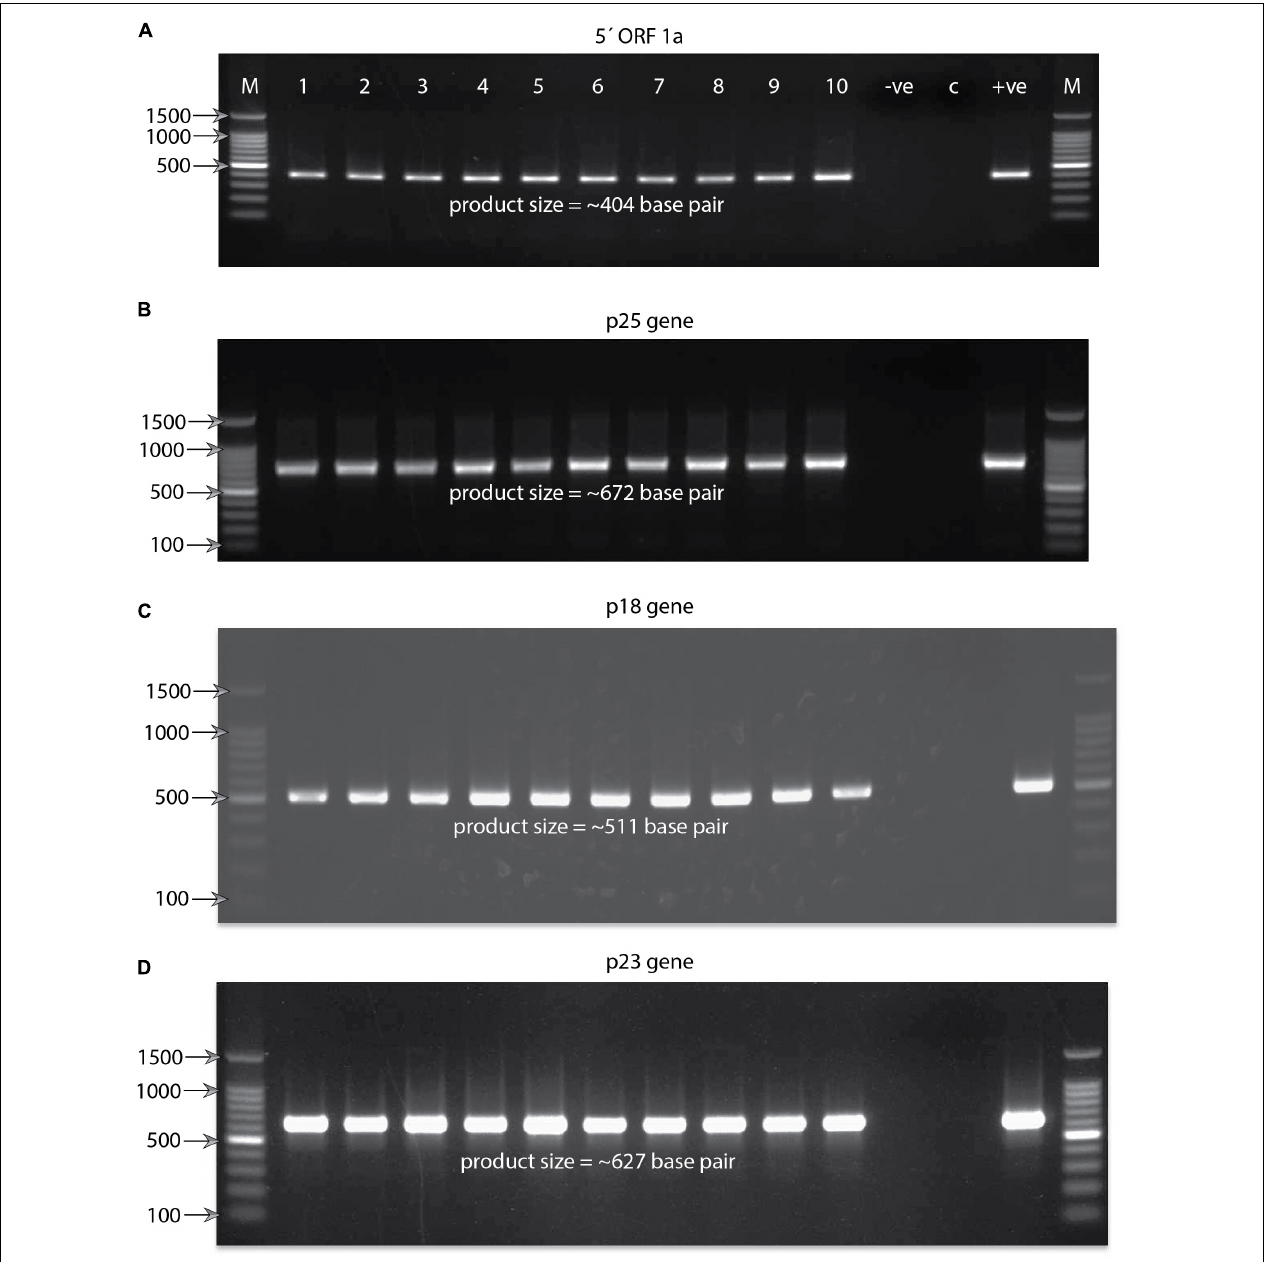
FIGURE 3 | Agarose gel electrophoresis pictures showing RT-PCR-amplified product. (A) Product size of ( ∼ 404) base pair obtained targeting the 5 (cid:48) ORF1a gene against the Bhutanese CTV variants. At the top of the gel lanes from right to left are labeled as follows: lane M, 100-base-pair DNA ladder; lanes 1–10, representatives of the Bhutanese CTV variants; lane − ve, reaction control; lane C, healthy plant control; and lane + ve, positive control. For clarity, labeling is not shown for the other three gel pictures. The same labeling of the first gel applies to all four gel pictures. Some of the significant DNA ladder sizes are labeled and shown with the help of arrows. (B) Gel showing the RT-PCR product size of ∼ 672 base pairs obtained targeting the p25 coat protein gene of the Bhutanese CTV variants. (C) Gel showing the RT-PCR product size of ∼ 511 base pairs obtained targeted against the p18 gene of the Bhutanese CTV variants. (D) Gel showing the RT-PCR product size of ∼ 627 base pairs targeted against the RNA binding p23 gene of the Bhutanese CTV variants. Primer pairs used to amplify these products are mentioned in Figure 2B and section “Materials and